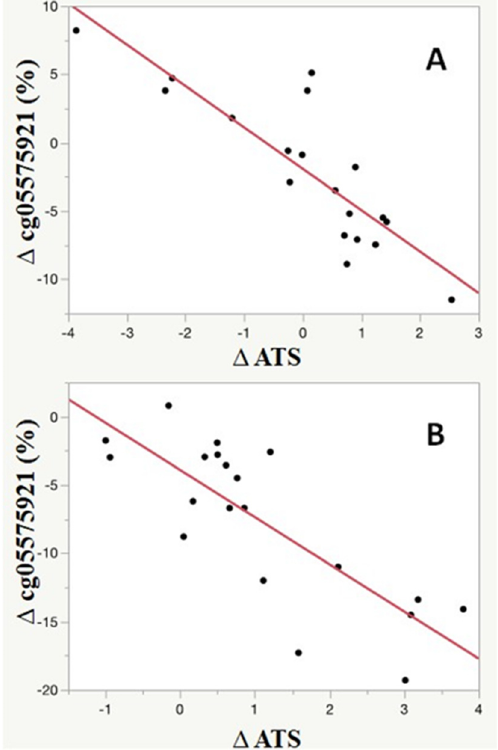
Figure 3. The relationship between the 90-day changes in cg05575921 methylation and ATS values for those who did not fully quit smoking ( A ; n = 19) and those who did fully quit smoking ( B ; n = 20). Although the overall magnitude of remethylation was greater in the quitters ( B ), the change ( ∆ ) in ATS score as a function of reduction in Scheme 05575921 was highly correlated with ATS values for both quitters ( B , n = 20, p < 0.0001; adjusted R 2 = 0.62) and non-quitters ( A , n = 19, p < 0.0001; adjusted R 2 = 0.70).